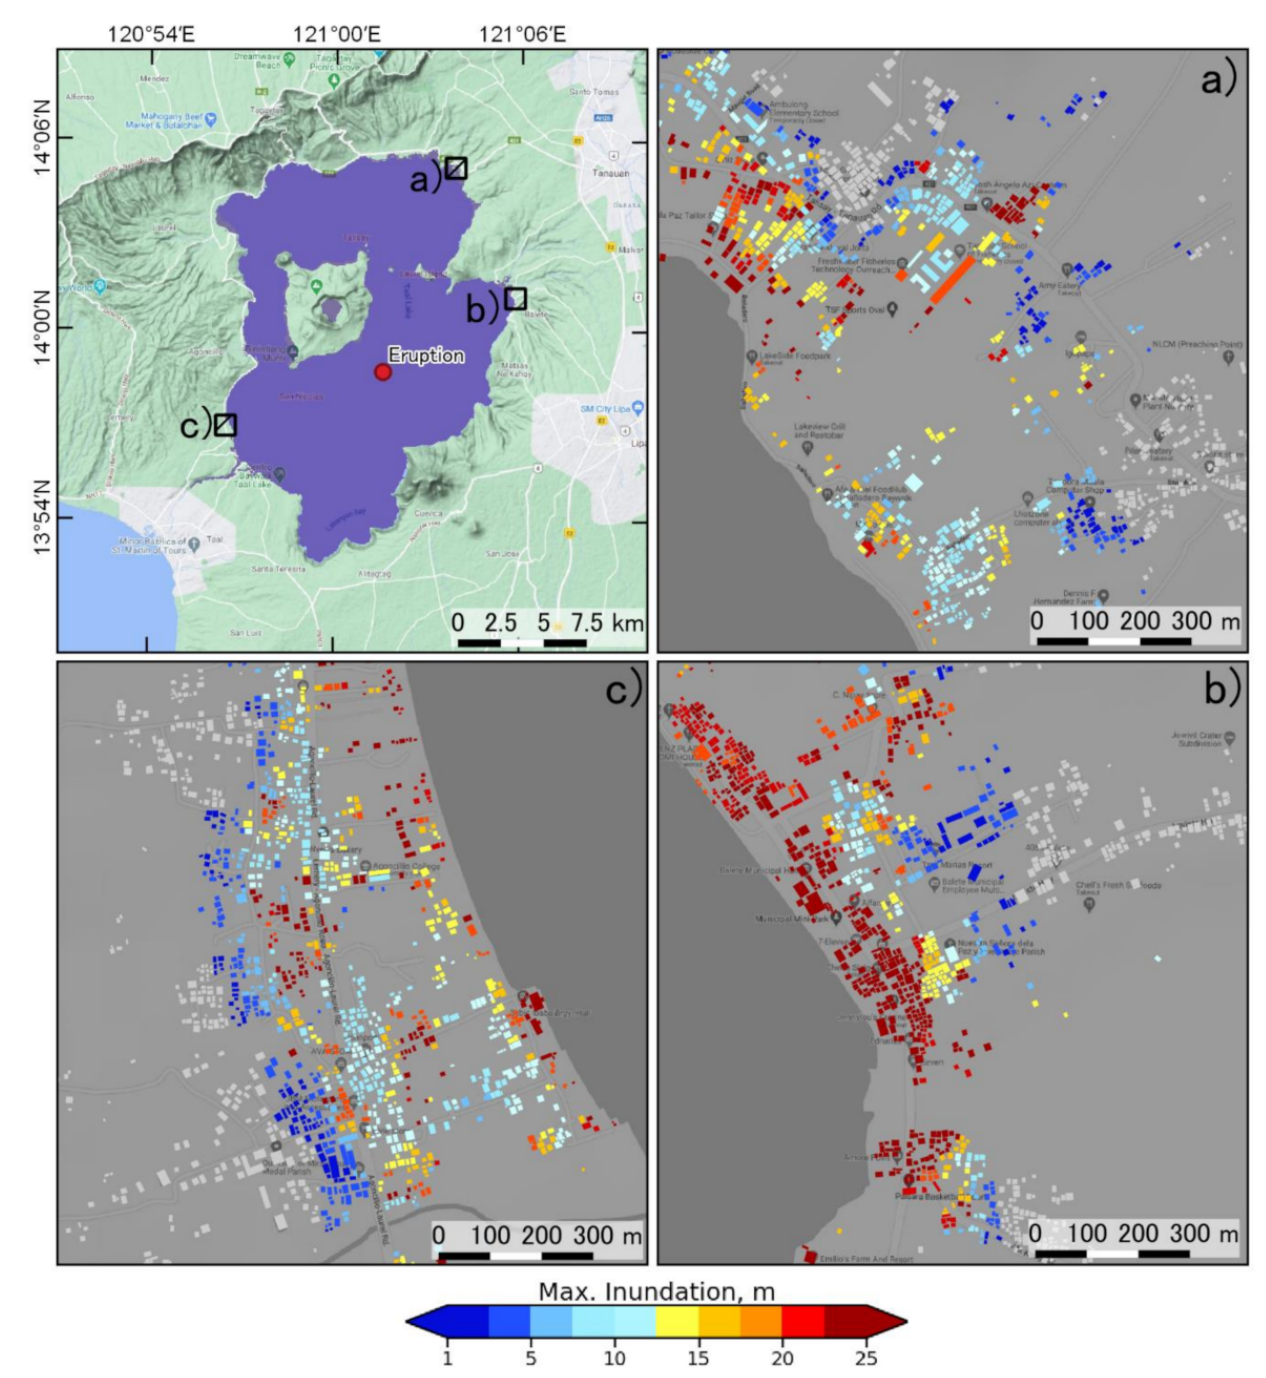
Figure 9. Tsunami hazard map showing the maximum inundation depths for the buildings with a probability of 1/500 in some example areas. ( a ) northern coastal area, ( b ) coastal area near to the eruption point, and ( c ) southern coastal